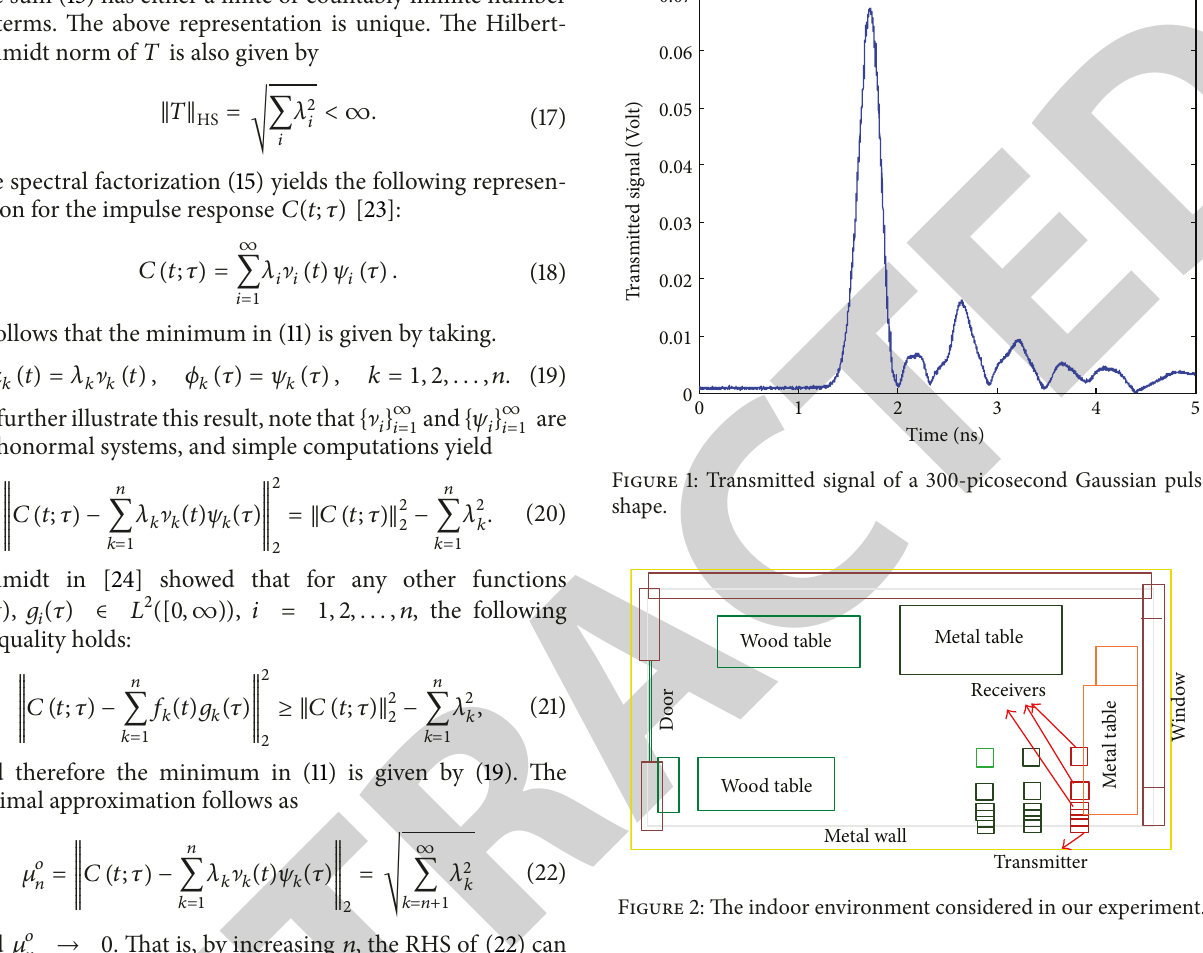
where 𝐼 𝑘𝑙 (𝑡) and 𝑄 𝑘𝑙 (𝑡) are, respectively, the inphase and 𝑄 (𝑡) are, quadrature component processes, 𝑋 𝐼 𝑘𝑙 (𝑡) and 𝑋 𝑘𝑙 respectively, the state vectors of the inphase and quadrature 𝑄 (𝑡)} are two independent components, {𝑊 𝐼 𝑘𝑙 (𝑡)} 𝑡≥0 and {𝑊 𝑘𝑙 𝑡≥0 standard Brownian motions which correspond to the inphase 𝑄 (𝑡) , and quadrature components, respectively, and 𝐴 𝐼 𝑘𝑙 (𝑡) , 𝐴 𝑘𝑙 (𝑡) , 𝐵 𝑄 (𝑡) , 𝐻 𝐼 (𝑡) , and 𝐻 𝑄 (𝑡) are matrices of appropriate 𝐵 𝐼 𝑘𝑙 𝑘𝑙 𝑘𝑙 𝑘𝑙 dimensions. Note that 𝐼 𝑘𝑙 (𝑡) and 𝑄 𝑘𝑙 (𝑡) are two independent Gaussian processes with zero-mean and equal variances; that is, Var (𝐼 𝑘𝑙 (𝑡)) = Var (𝑄 𝑘𝑙 (𝑡)) = Var (𝑁 𝑘𝑙 (𝑡)) , where 𝑁 𝑘𝑙 (𝑡) is either 𝐼 𝑘𝑙 (𝑡) or 𝑄 𝑘𝑙 (𝑡) [13]. They are related to the tap weight (𝑡, 𝜏) and phase 𝜙 (𝑡, 𝜏) by the expressions 𝑎 (𝑡, 𝜏) = 𝑎 𝑘𝑙 𝑘𝑙 𝑘𝑙 √𝐼 2 (𝑡, 𝜏) + 𝑄 2 (𝑡, 𝜏) and 𝜙 (𝑡, 𝜏) = arctan (𝑄 (𝑡, 𝜏)/𝐼 (𝑡, 𝜏)) , 𝑘𝑙 𝑘𝑙 𝑘𝑙 𝑘𝑙 𝑘𝑙 respectively. In the next section, the stochastic narrowband and UWB indoor channel models are